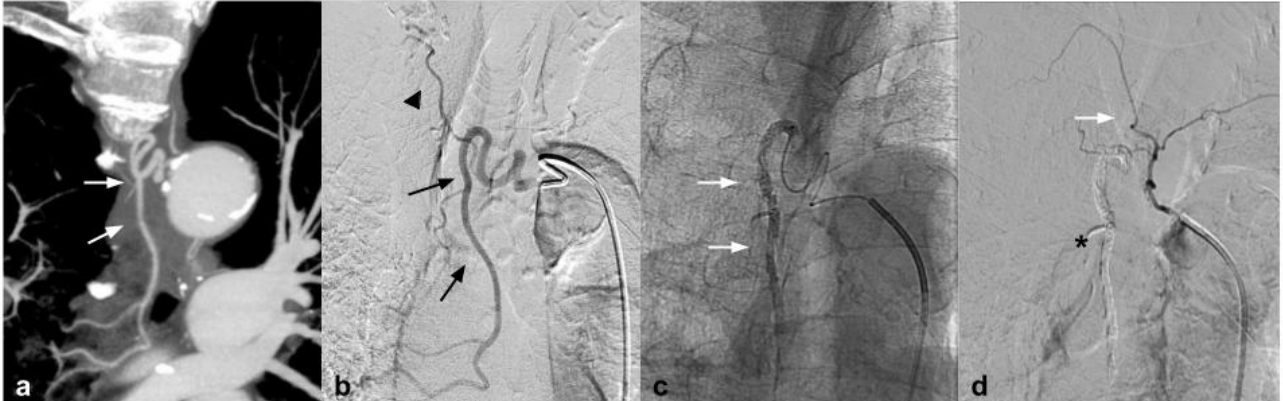
Figure 2. ( a ) Coronal CTA MIP demonstrates hypertrophic bronchial artery with tortuous course originating at 9:00 from the convexity of the aortic arch (white arrows); ( b ) DSA performed with Simmons 1 catheter at the level of the ostium of the bronchial artery confirms the presence of the hypertrophic vessel (black arrow) with a small tributary branch of the right upper lobe (arrow head); ( c ) single-shot fluoroscopy after embolization shows the presence of the microcatheter at the level of the proximal portion of the bronchial artery, with a Squid 12 cast completely occupying the main trunk (white arrows); ( d ) post-procedure DSA control demonstrates complete exclusion of the treated vessel (asterisk) with patency of the small branch for the right pulmonary upper lobe (white arrow).